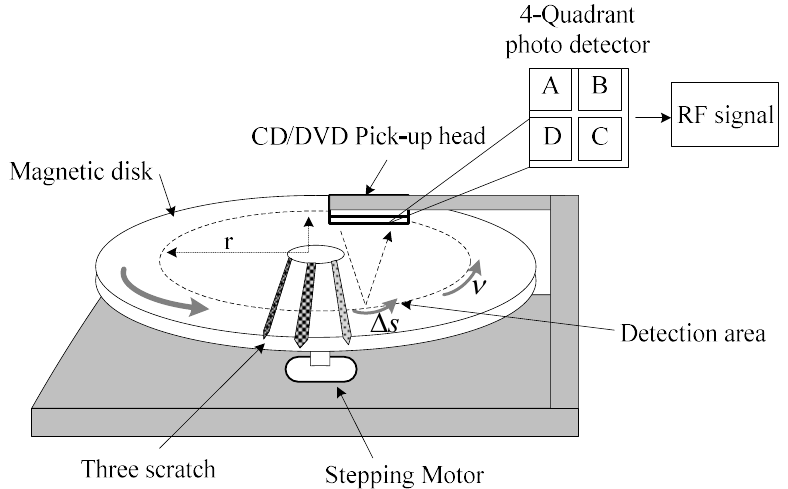
/ DVD pick-up head.